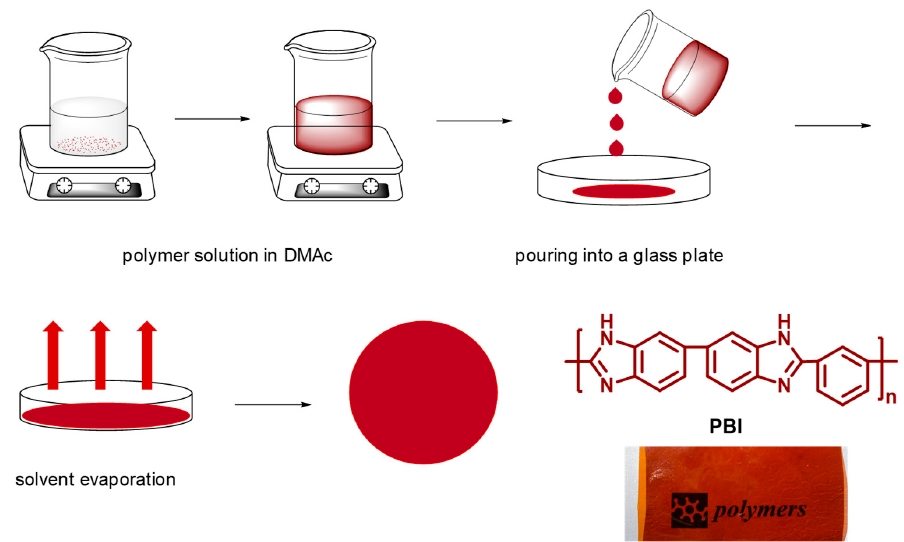
Figure 3. Schematic representation of polybenzimidazole (PBI) membrane preparation by the casting method.